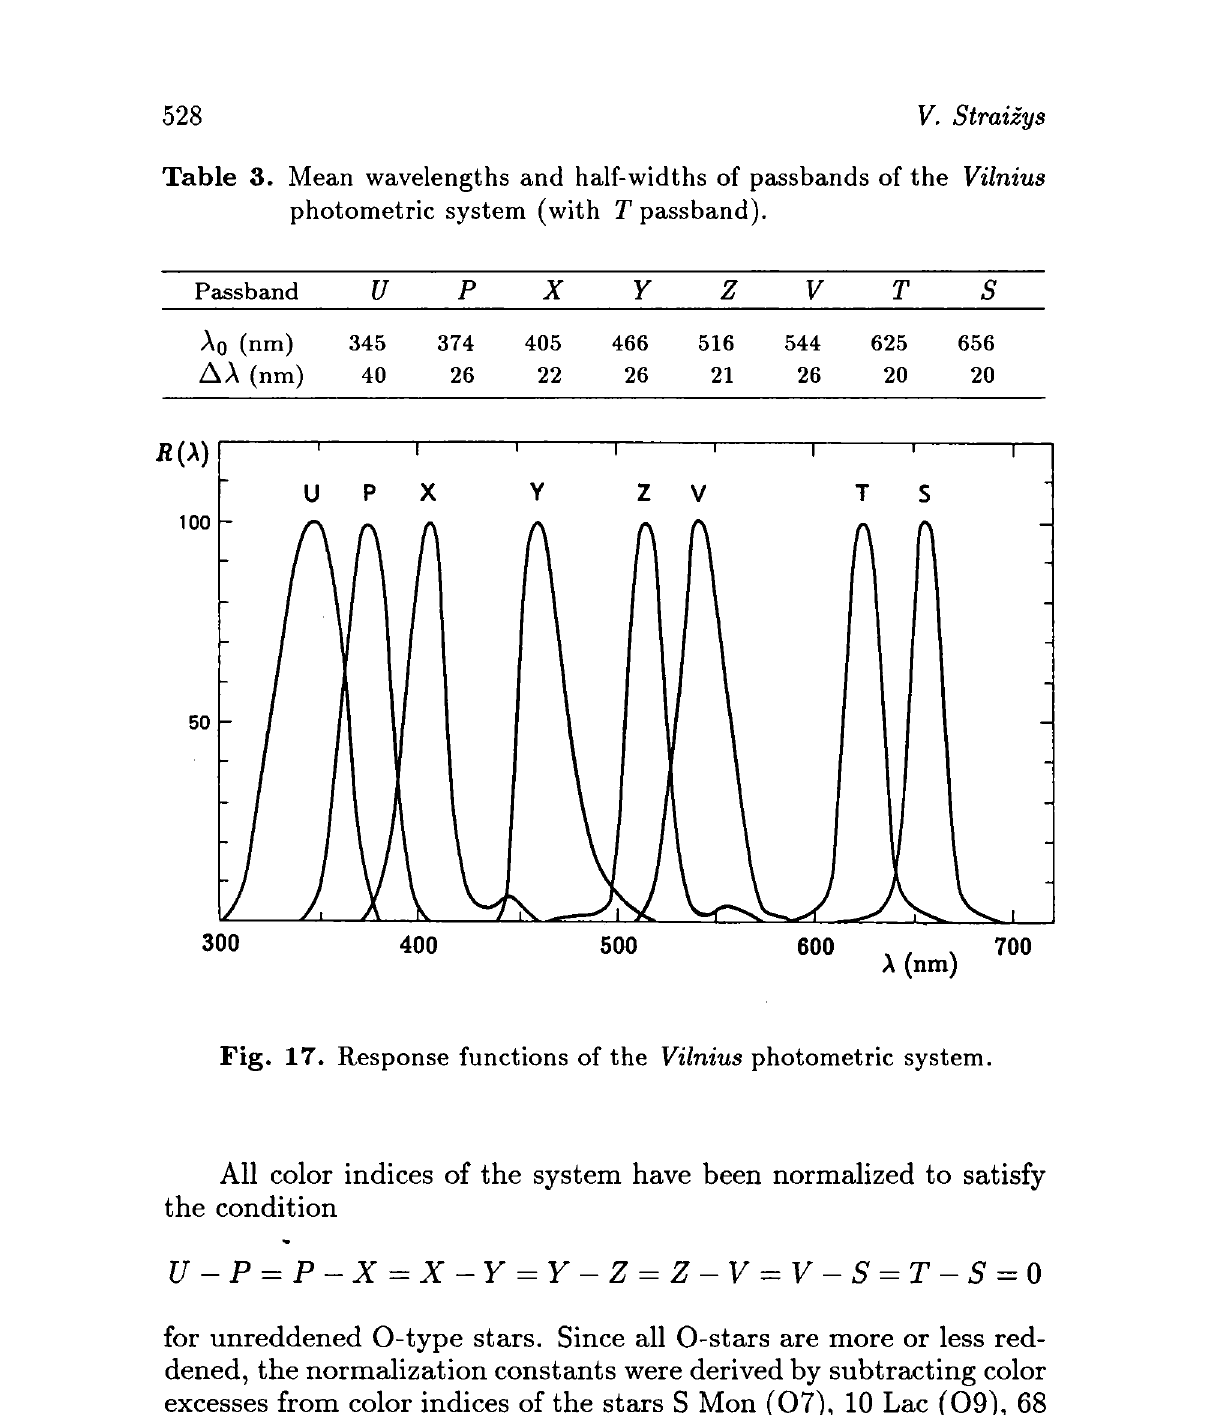
Table 3. Mean wavelengths and half-widths of passbands of the Vilnius photometric system (with T passband).